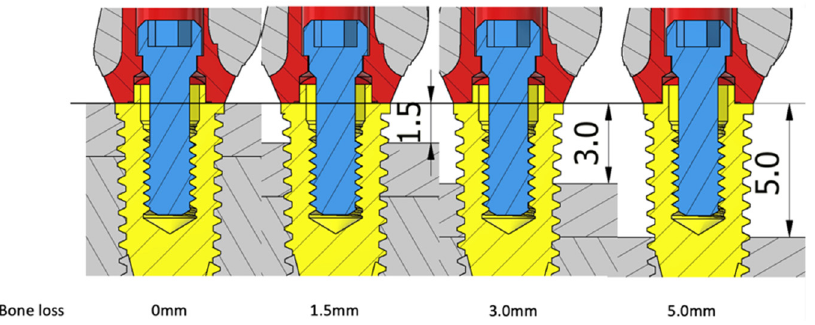
Figure 2. S groups with 0 mm (ST0 and SZ0), 1.5 mm (ST1.5 and SZ1.5), 3 mm (ST3 and SZ3), and 5 mm (ST5 and SZ5) bone loss.